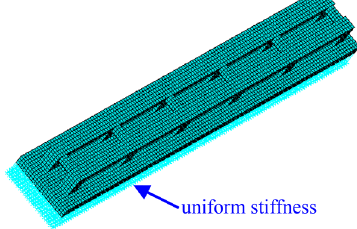
Fig. 3 At-ground structure FE model